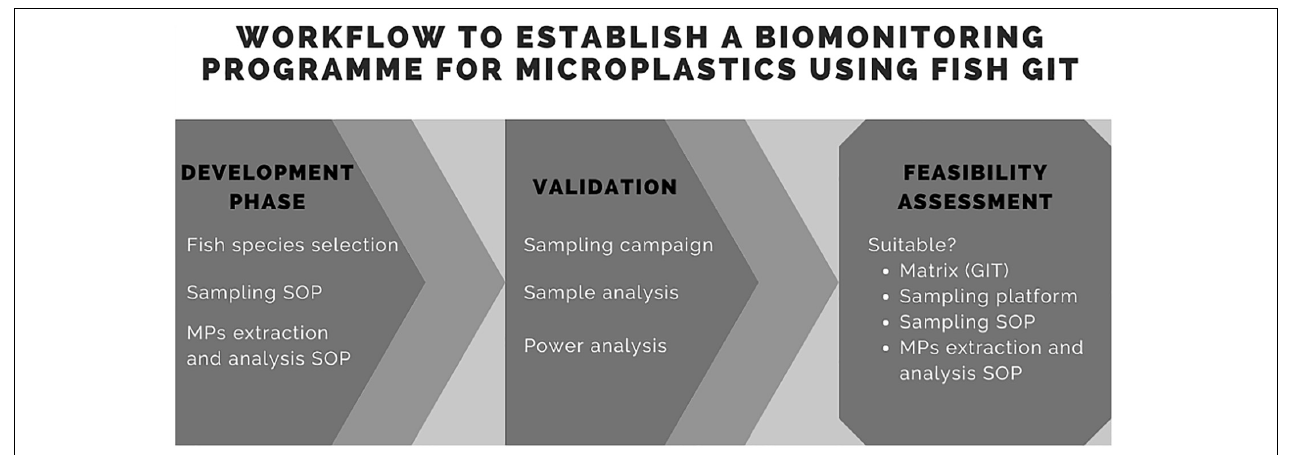
FIGURE 1 | Overview of the stepwise approach used to establish an assessment on microplastic biomonitoring in fish GIT.